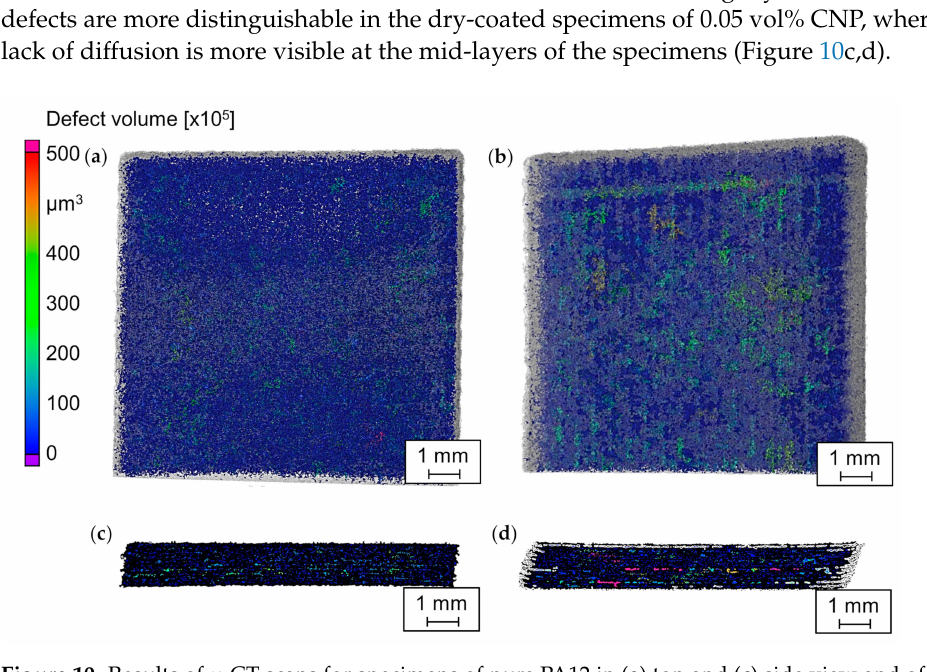
Figure 10. Results of µ -CT scans for specimens of pure PA12 in ( a ) top and ( c ) side view and of PA12 dry-coated with 0.05 vol% CNP in ( b ) top and ( d ) side